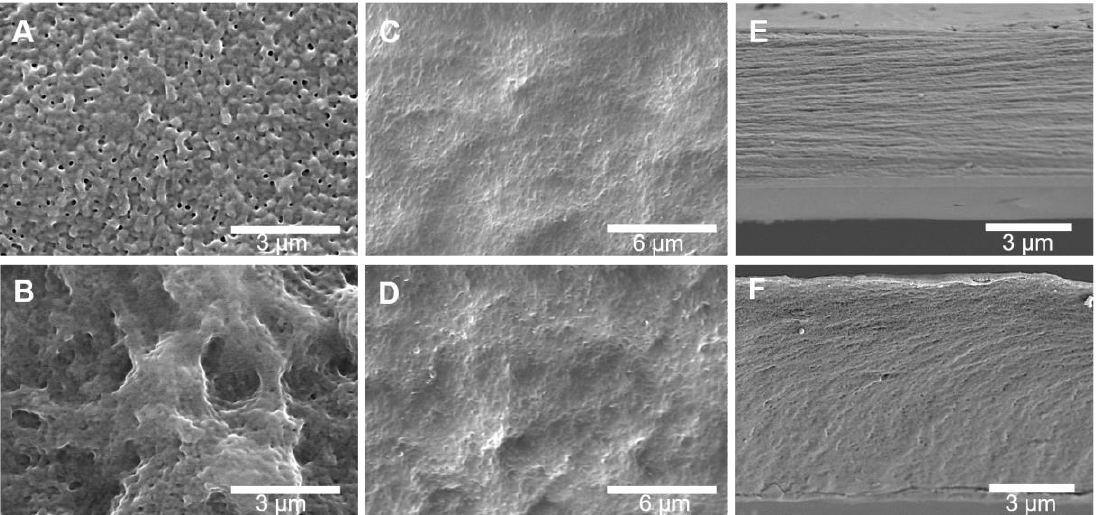
Figure 4. Representative scanning electron microscopy (SEM) images of the surfaces of ( A ) [CHT/HA] 200 (HA-ending side); ( B ) [CHT/HA-DN] 200 (HA-DN-ending side); ( C ) [CHT/HA] 200 (CHT- ending side); ( D ) [CHT/HA-DN] 200 (CHT-ending side). Representative SEM images of the